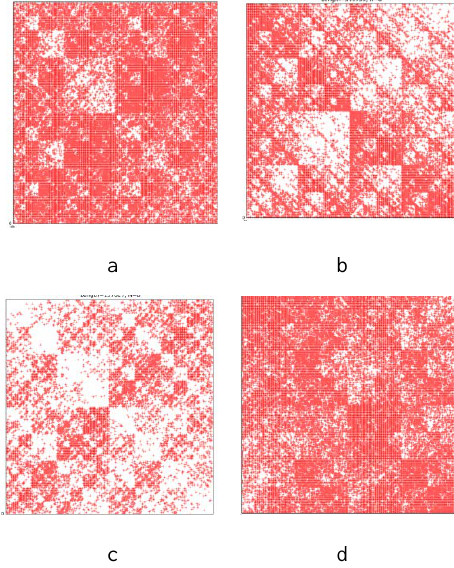
Fig. 2. Examples of two-dimensional visualization (abscissa axis: purine-pyrimidin, ordinate axis: amino-keto, a scaling parameter N = 8) of the